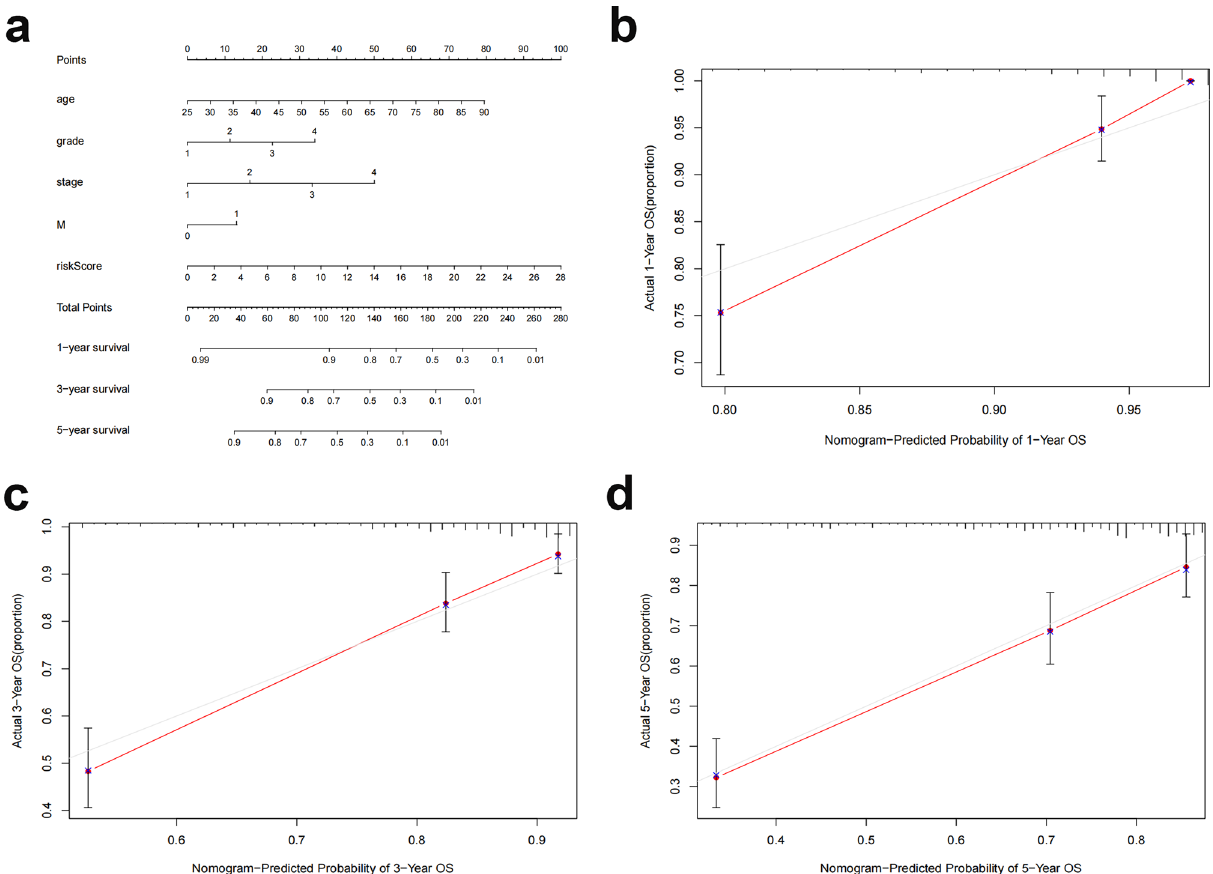
Figure 7. Creation and validation of a nomogram. ( a ) Clinicopathological factors and risk scores combined with a nomogram to predict survival in ccRCC patients at 1, 3, and 5 years. ( b – d ) Calibration curves to assess whether expected survival at 1, 3, and 5 years agrees with actual OS rates. M, metastasis; OS, overall survival; ccRCC, clear cell renal cell